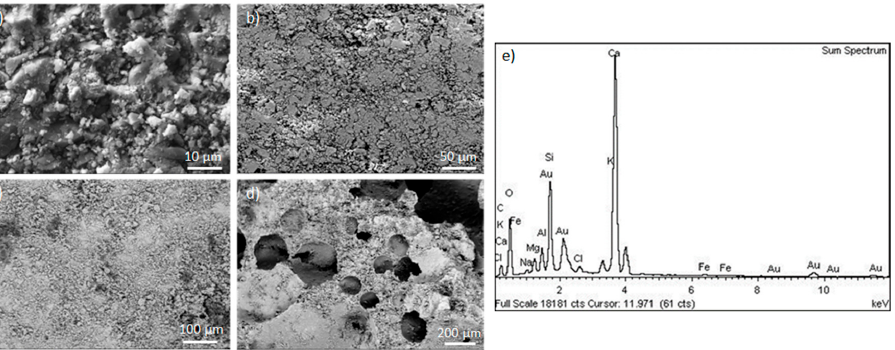
Figure 5. SEM micrographs (( a – d ), at increasing enlargements) and EDX analysis of the monolith ( e ).